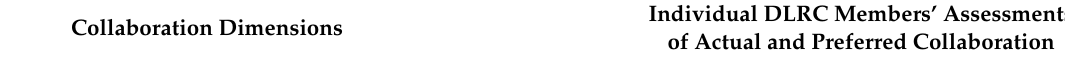
Table 1. SI framework for collaboration in